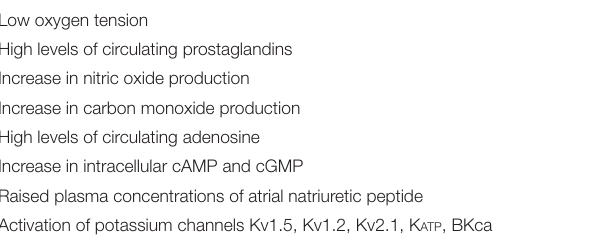
TABLE 1 | Factors that maintain ductal patency in utero